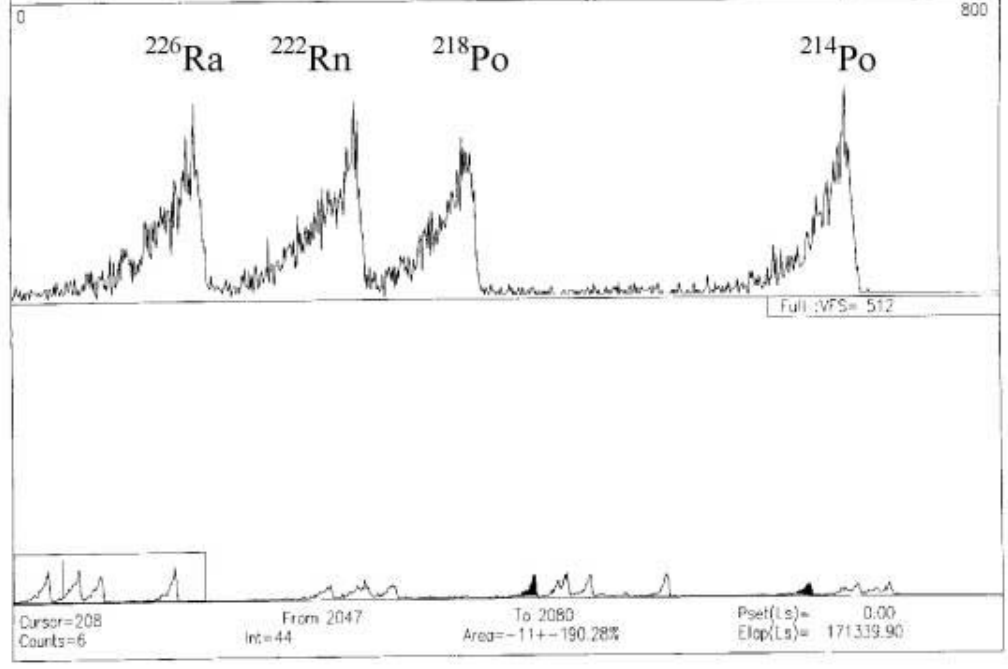
FIGURE 2B . Spectrum for the same sample measured a month